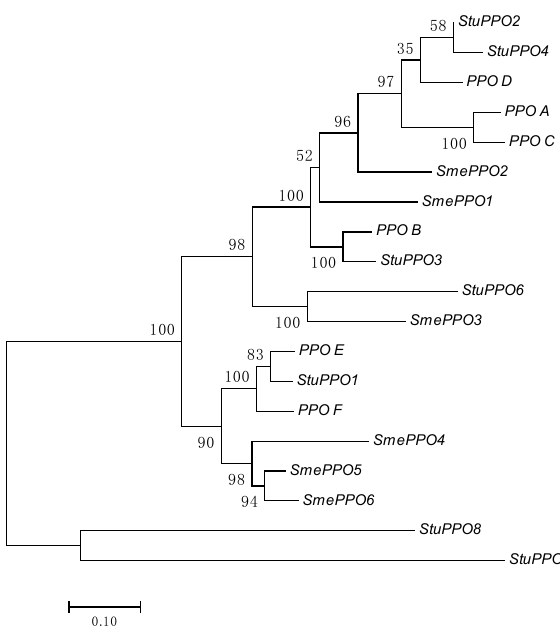
Figure 2. Evolutionary relationships among Solanaceae PPOs inferred by using the Maximum Likelihood method. Evolutionary analyses were conducted in MEGA7 (http://www.megasoftware.net/). Numbers below branches indicate 1000 bootstrap support values.